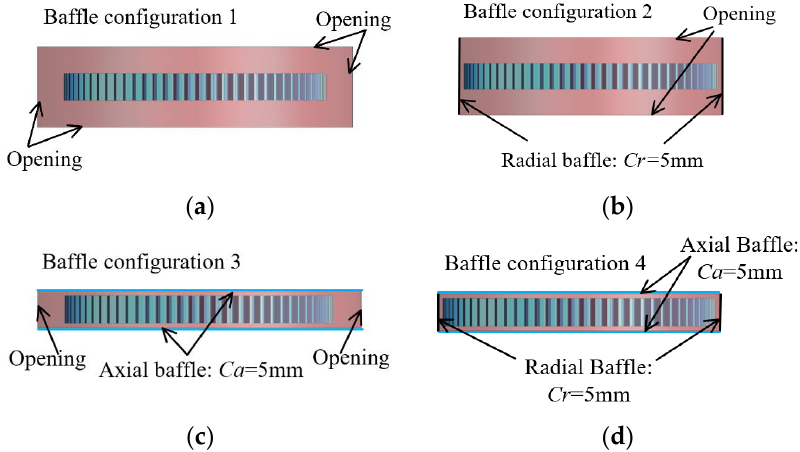
Figure 9. Four baffle configurations: ( a ) Baffle configuration 1: non-baffle; ( b ) Baffle configuration 2: radial baffle only; ( c ) Baffle configuration 3: axial baffle only; ( d ) Baffle configuration 4: combined baffle comprising axial baffle and radial baffle.